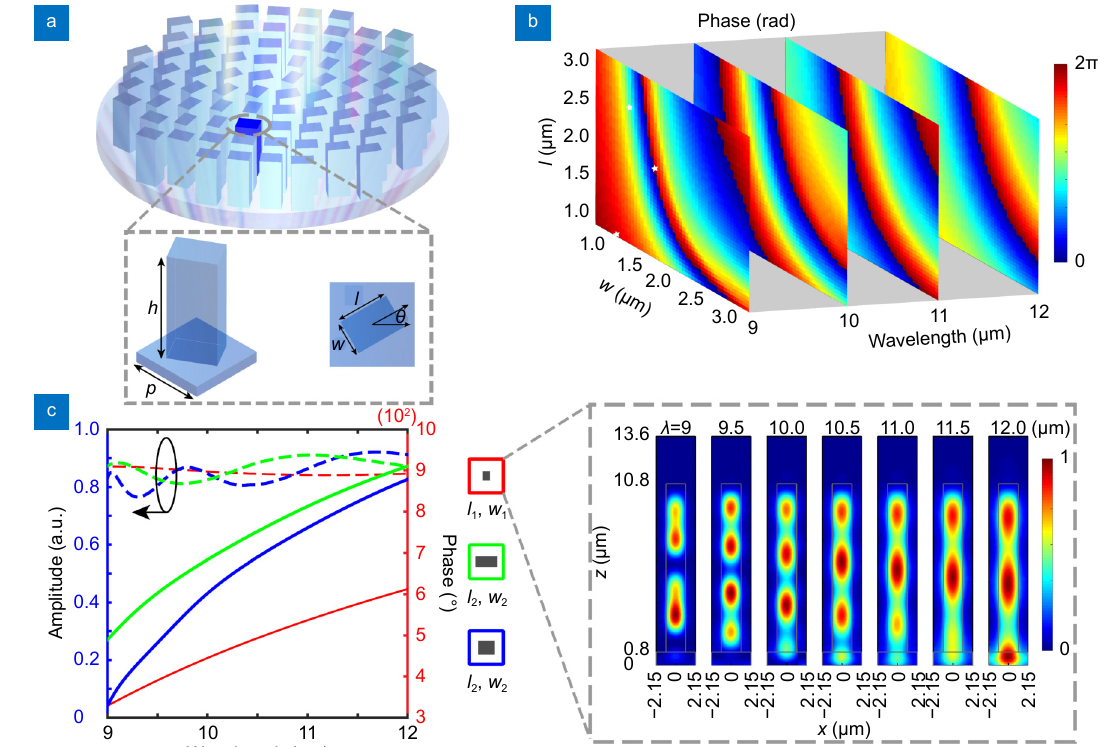
Fig. 2 | Optical responses of the unit cells. ( a ) Schematic illustration of the subwavelength structures. ( b ) Phase response of the database to X-polarization at discrete sampling wavelengths. ( c ) The amplitude and phase profiles of the unit cells ( l 1 , w 1 , l 2 , w 2 , l 3 , w 3 ) are marked with white pentagrams in Fig. 2(b). The phase profiles have approximately linear relations with wavelength. The inset is the magnetic energy density profile for the unit cell with l 1 and w 1 at wavelengths 9, 9.5, 10, 10.5, 11, 11.5, and 12 μm. The black line is the outline of the unit cell. The magnetic en- ergy is strongly concentrated in the dielectric